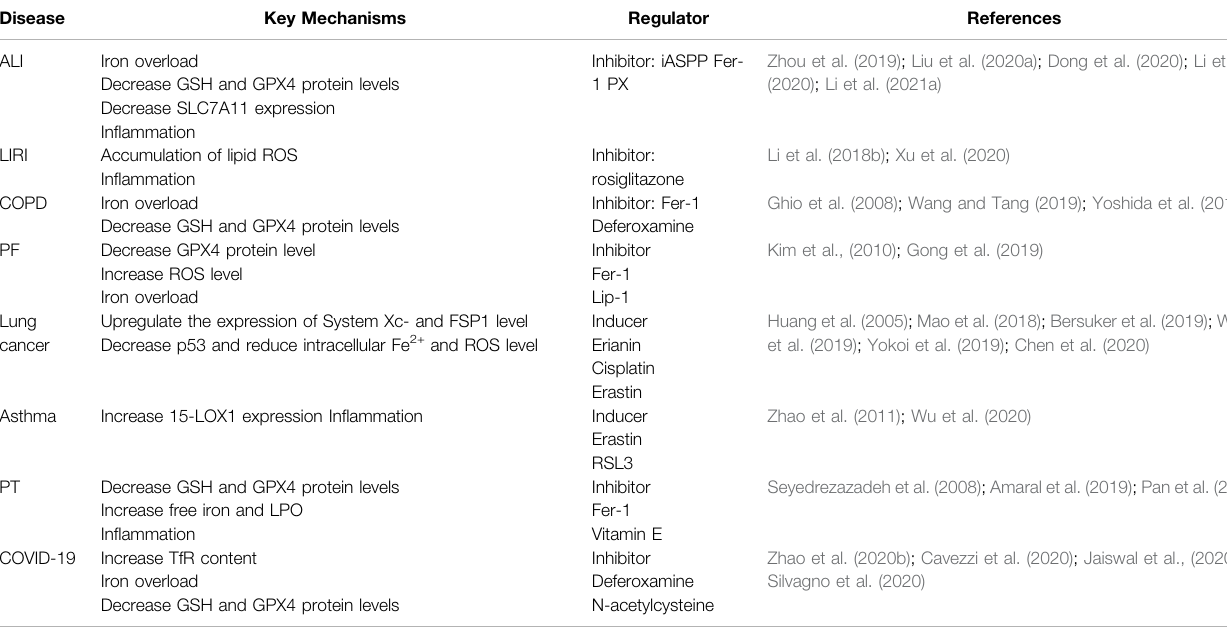
TABLE 1 | Key mechanisms and regulators of ferroptosis in lung diseases. Disease Key